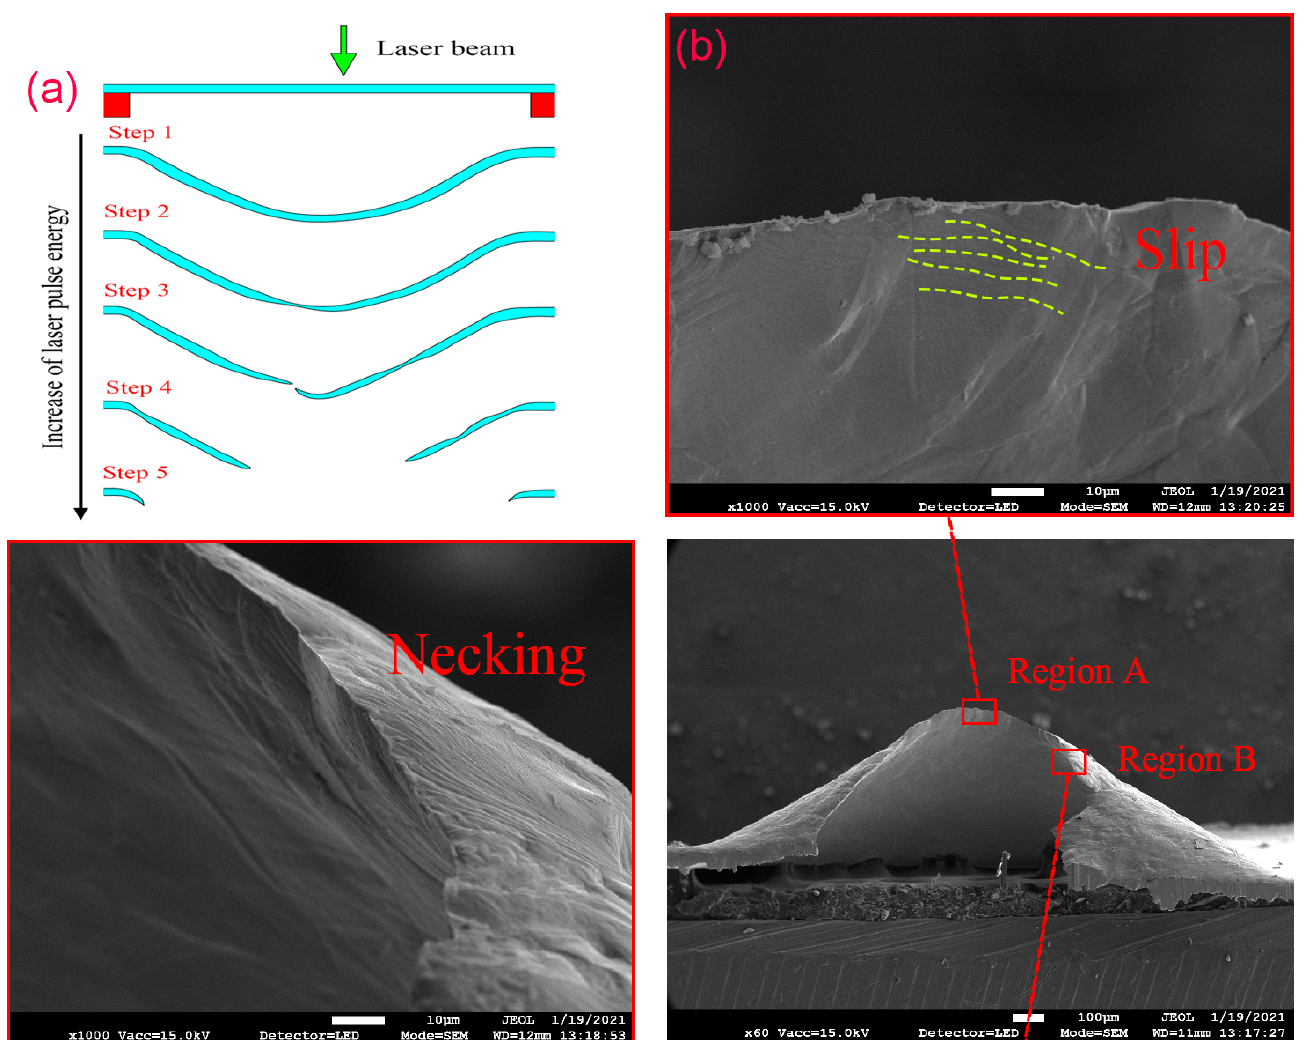
Figure 8. ( a ) Schematic diagram of μ LFDB and fracture mode under different laser pulse energies; ( b ) SEM morphology of fractured parts annealing at 650 °C.